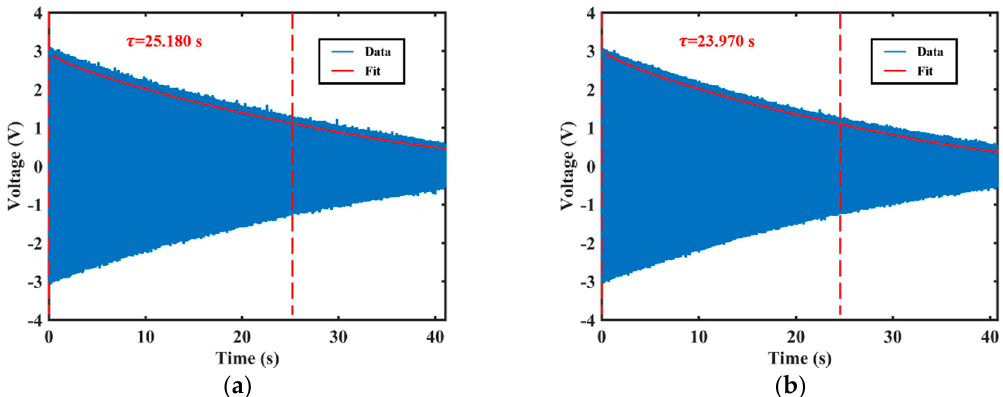
Figure 9. The decay time constant measured by ring-down time method: ( a ) The decay time constant excited by the low-frequency axis; ( b ) The decay time constant excited by the high-frequency axis. The variation of the decay time is about 1.210 s, and the variation of the Q factor is about 2.838 × 10 4 . The frequency mismatch of the resonator is about 0.340 Hz, as shown in Figure 10.